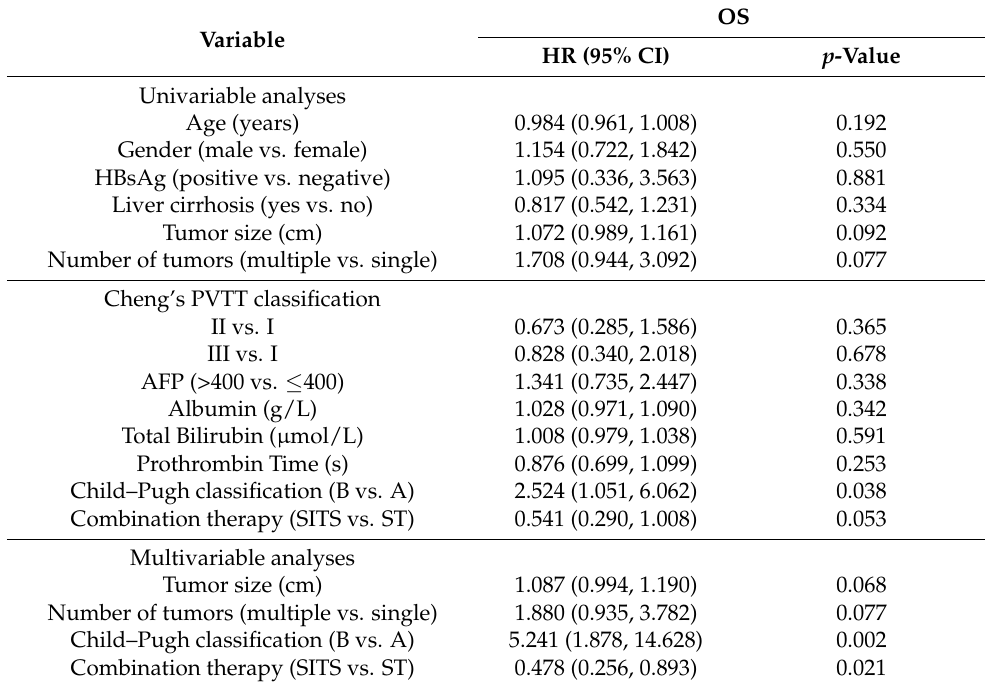
Table 4. Univariable and multivariable analyses of risk factors for OS in advanced HCC cases accompanied by